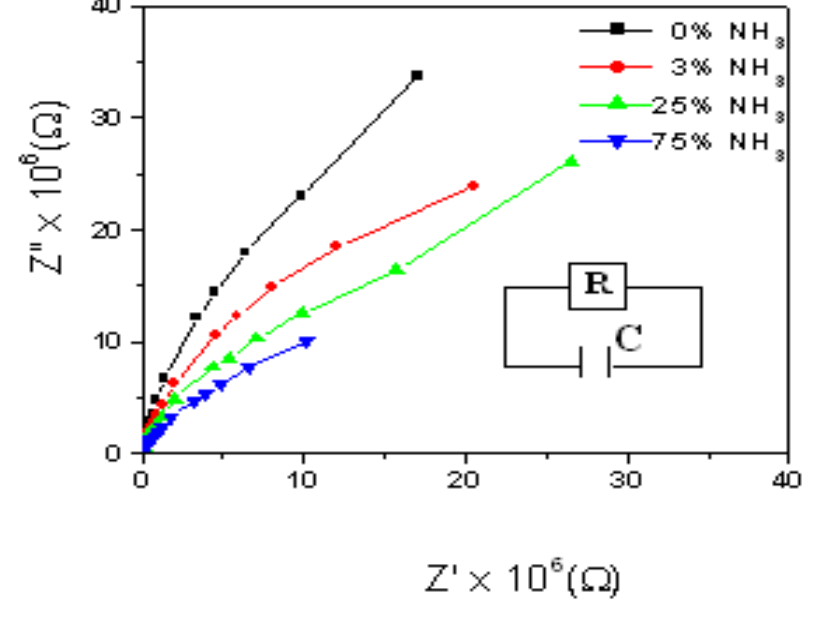
Figure 6. Cole-Cole plots of CdS dispersed PE based TEMPOS structures at different NH concentrations (inset: equivalent